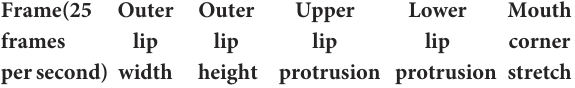
TABLE 5 The dynamic data value of each part of “ ”/ka/ in Tibetan Xiahe dialect (unit: